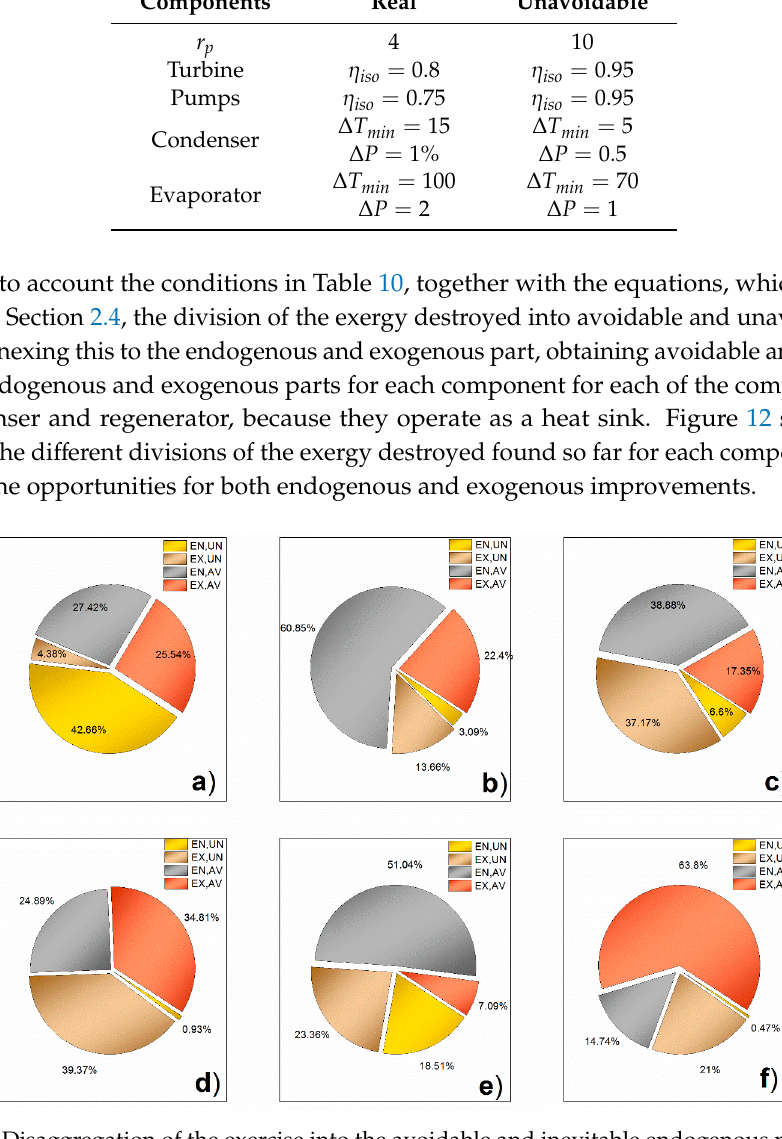
Figure 12. Disaggregation of the exercise into the avoidable and inevitable endogenous portion and the avoidable and inevitable exogenous component part for ( a ) Pump 1; ( b ) Pump 2; ( c ) Evaporator; ( d ) Heat exchanger 1 (ITC 1); ( e ) Regenerator; and ( f ) Turbine.